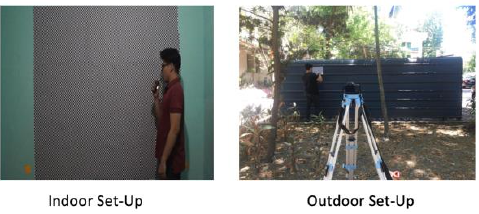
Figure 4. Environment